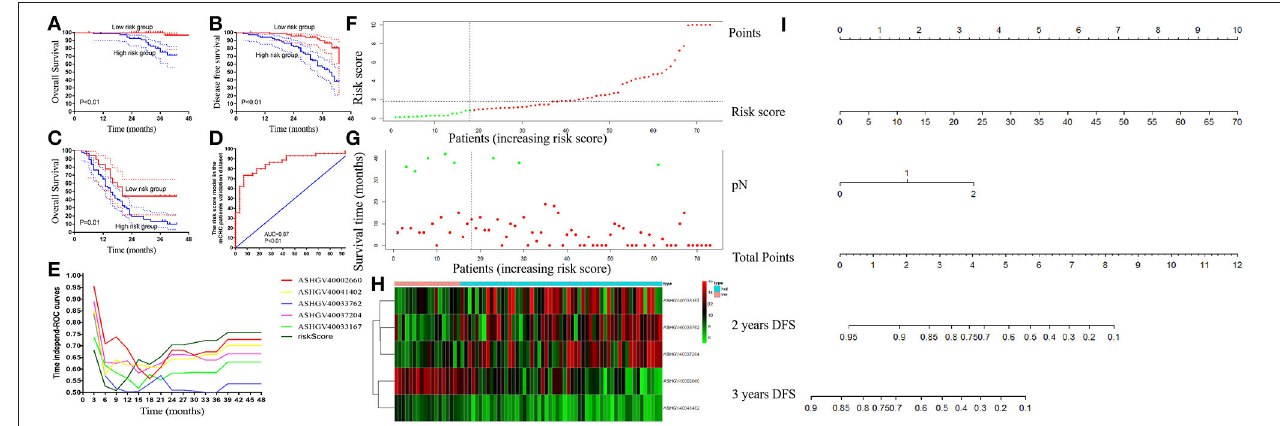
FIGURE 8 | External validation of risk score in the non-metastatic colorectal cancer (CRC) and metastatic colorectal cancer (mCRC) patients. (A,B) The Kaplan–Meier analysis for the overall survival (A) and disease-free survival (B) of the risk score in the non-metastatic CRC patients. (C) The Kaplan–Meier analysis for the overall survival of the risk score in mCRC patients. (D) Receiver operating characteristic (ROC) curves and area under the ROC curve (AUC) analysis to evaluate the predictive efficiency of the risk score in mCRC patients for FOLFOX chemotherapy. (E) Time-dependent AUC curves of the hub lncRNAs and risk factor models for the prediction of disease-free survival (DFS) in the non-metastatic CRC patients. (F–H) The risk factor model of the hub lncRNAs in mCRC patients. (F) LncRNA risk score distribution of 73 mCRC patients. (G) Survival status in mCRC patients ( N = 73). (H) Heatmap of the hub lncRNAs expression. Red: high expression; blue: low expression. (I) Nomogram developed for prediction of disease-free survival in the non-metastatic CRC